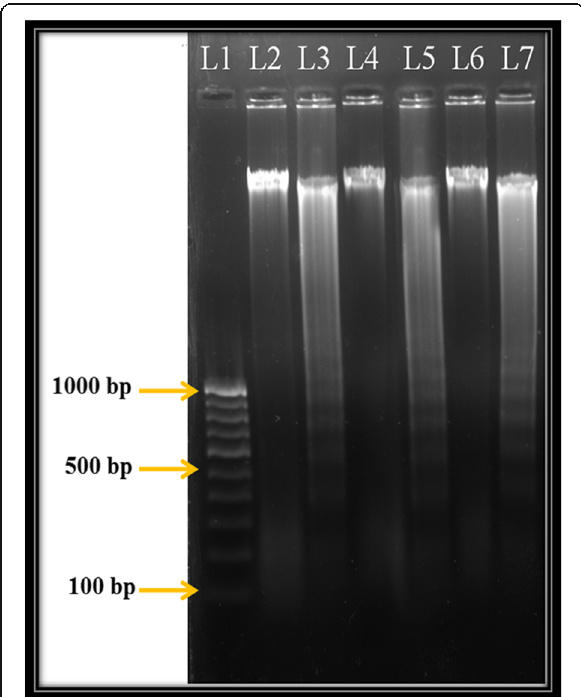
Fig. 4 The methanolic extract of B. pilosa induced DNA